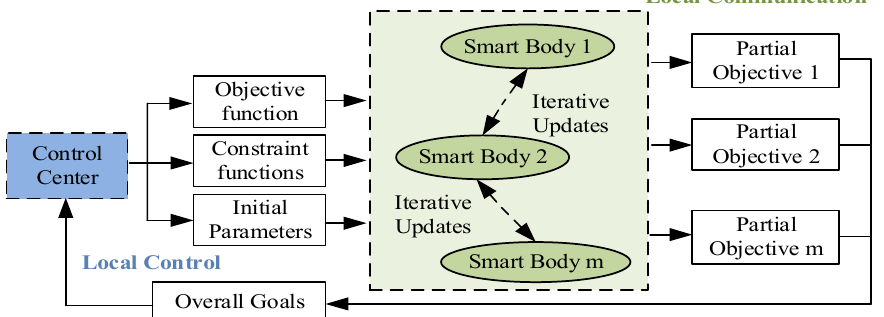
Figure 5. Balanced control structure diagram.